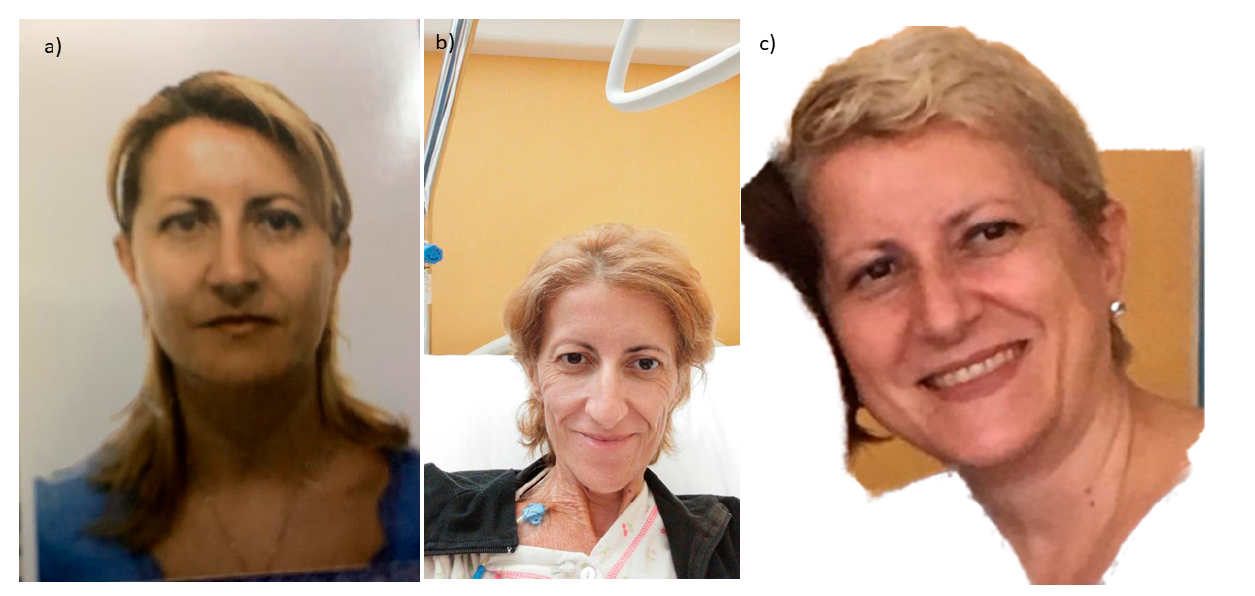
Figure 2. Reversibility of cancer cachexia. The images report the case of a female patient with advanced ovarian cancer, which exemplify the change of clinical objective status of a patient before cancer diagnosis ( a ), at cancer diagnosis with features of cancer cachexia ( b ), and after surgical and medical treatment that obtained a complete response with clinical resolution of cancer cachexia ( c ). The patient gave signed informed consent for the publication of the images.